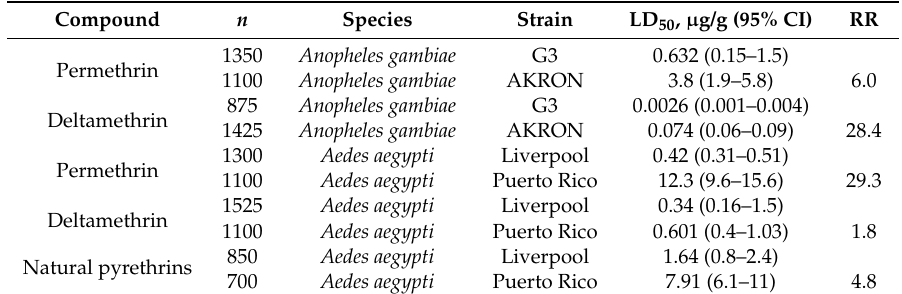
Table 1. LD 50 values and resistance ratios associated with each synthetic pyrethroid